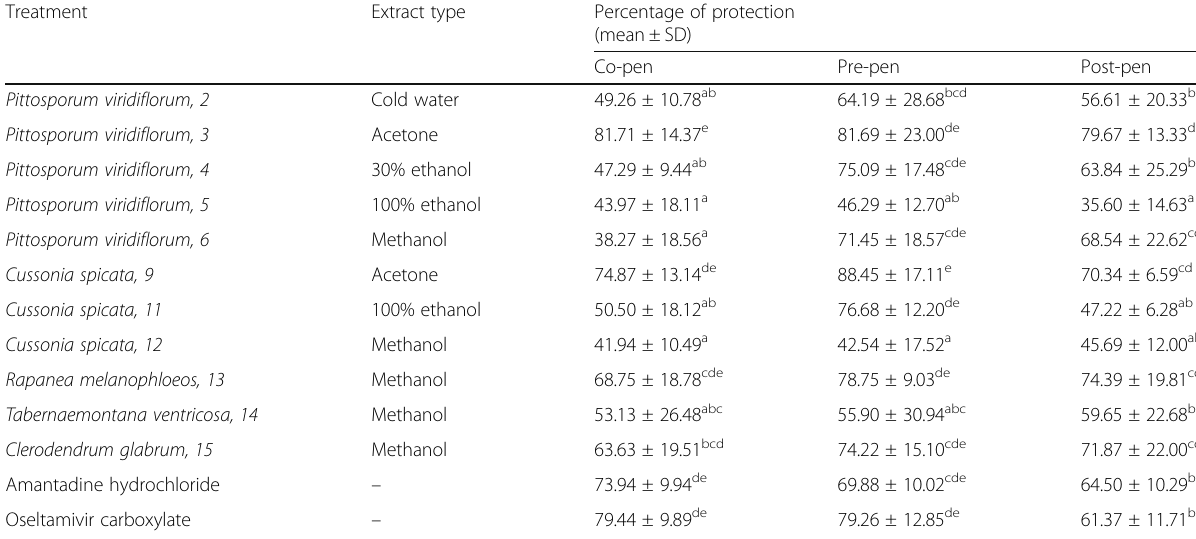
Table 5 Cellular percentage of protection in combined treatments with virus compared to control groups